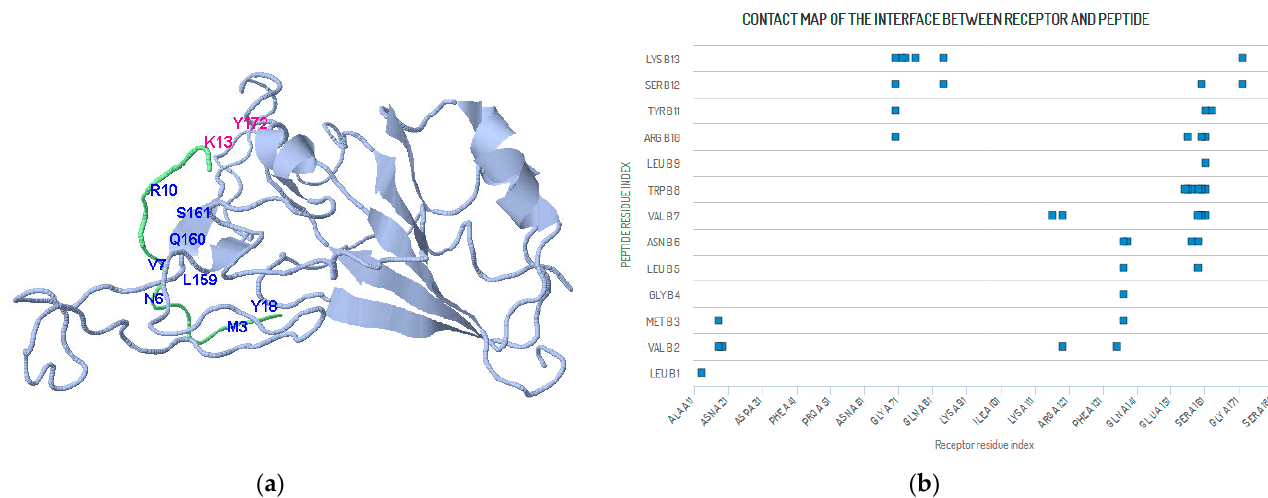
Figure 4. ( a ) Docking of antisense peptide KLTIKGDVSIPKVGWLPQPIV to RBD of S1 SARS-CoV-2 by means of a CABS- dock server (Table S2: model 1) [28]. Pairs of peptide/receptor residuals: in 3 ′ → 5 ′ direction marked blue, in 5 ′ → 3 ′ direc- tion marked red, otherwise magenta; ( b ) Contact map of the interface between antisense peptide and its receptor residues in a complex closer than 4.5 Å (Tables A3 and S2: model 1).